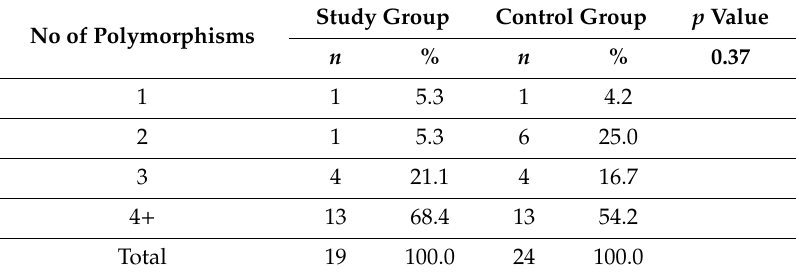
Table 4. Number of polymorphisms in both groups.